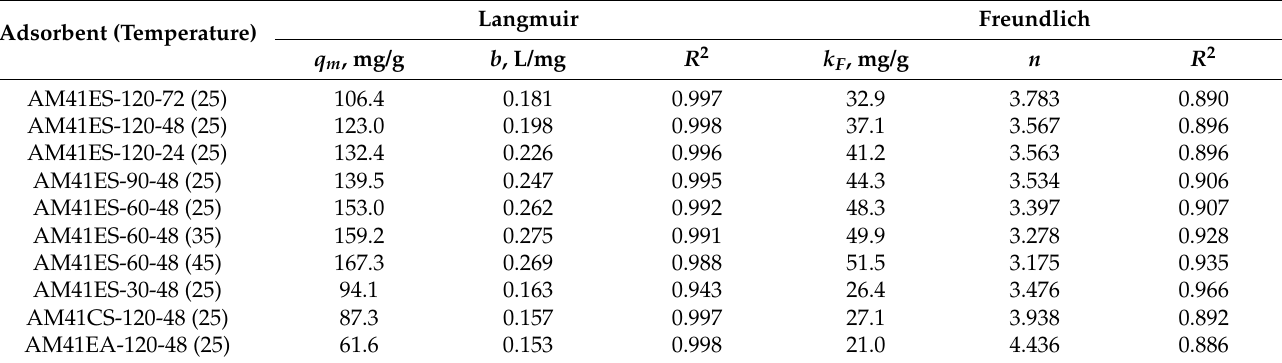
Table 8. Characteristic parameters and constants of Langmuir and Freundlich models and the correlation coefficients R 2 . Adsorbent (Temperature)